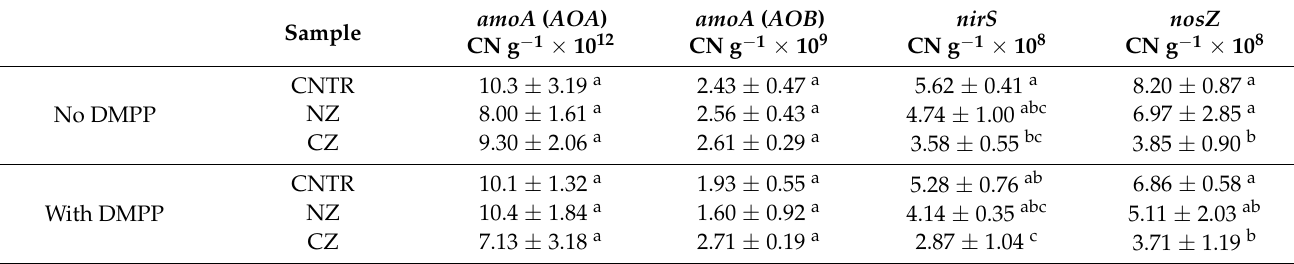
Table 3. Copy numbers (CN) of the functional genes for archaeal ammonia oxidation ( amoA AOA ), and bacterial ammonia oxidation ( amoA AOB ), as well as nitrite reductase ( nirS ) and nitrous oxide reductase ( nosZ ). Values are expressed as mean ± standard deviation (3 replicates). Different superscript letters express significant differences as a result of ANOVA and Tukey-HSD statistical tests ( p <